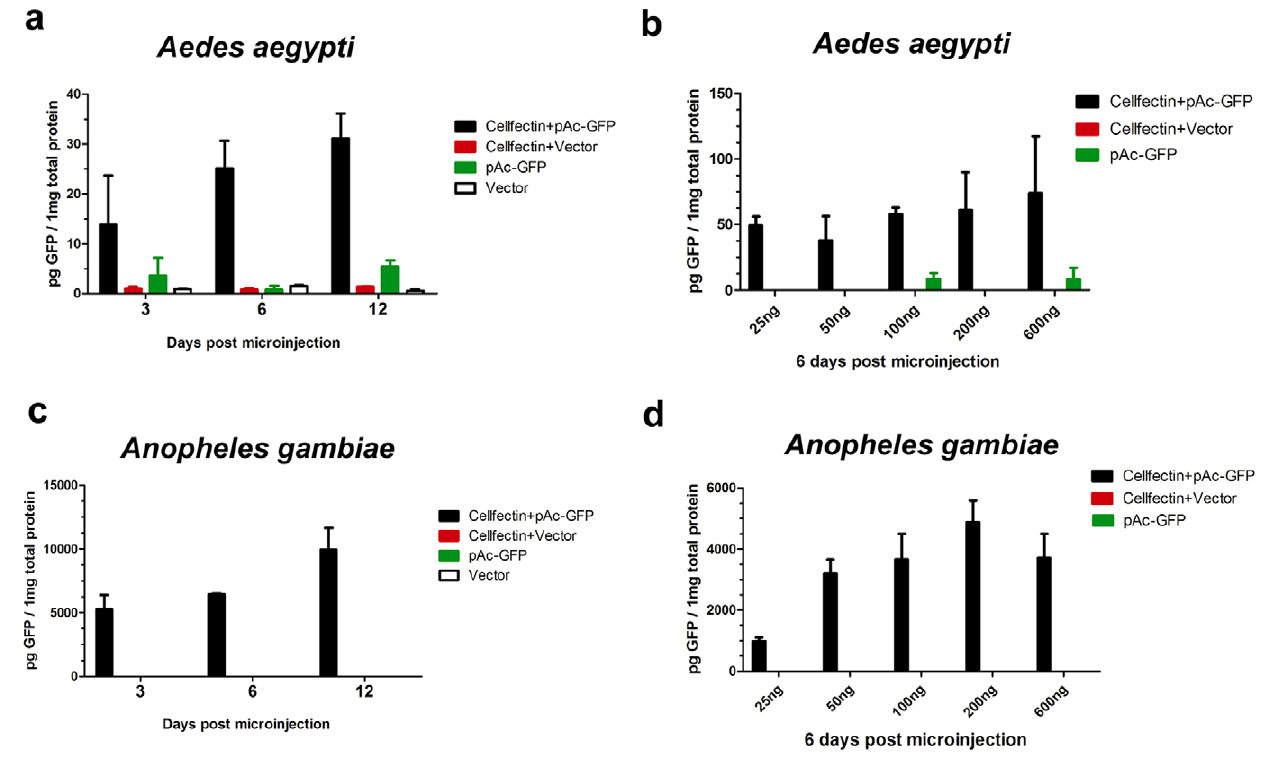
Figure 2. Cellfectin II H enhances GFP protein expression in Ae.aegypti . Cellfectin II H facilitates GFP expression in Ae. aegypti ( a ) and in An. gambiae ( c ). 200 ng plasmids were microinjected into mosquitoes. The GFP protein concentration in whole mosquito lyses was measured by ELISA. Data are expressed as the mean 6 standard error from 3 independent experiments. Titration of the amount of plasmid DNA influences the GFP expression in Ae. aegypti ( b ) and in An. gambiae ( d ). 2-fold titrated plasmid DNA with Cellfectin II H was inoculated into mosquitoes. The treated mosquitoes were sacrificed at 6 days post microinjection and homogenated in tissue lysis buffer. The GFP protein level was determined by ELISA. Data are expressed as the mean 6 standard error from 3 independent experiments.